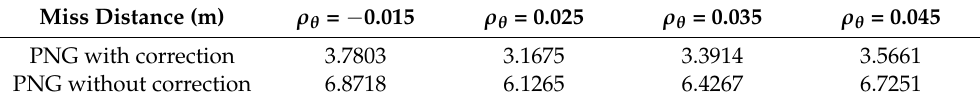
Table 1. Comparison of terminal miss distance for PNG with/without LOS angular rate correction. Miss Distance (m) ρ θ = − 0.015 ρ θ = 0.025 ρ θ = 0.035 ρ θ = 0.045 PNG with